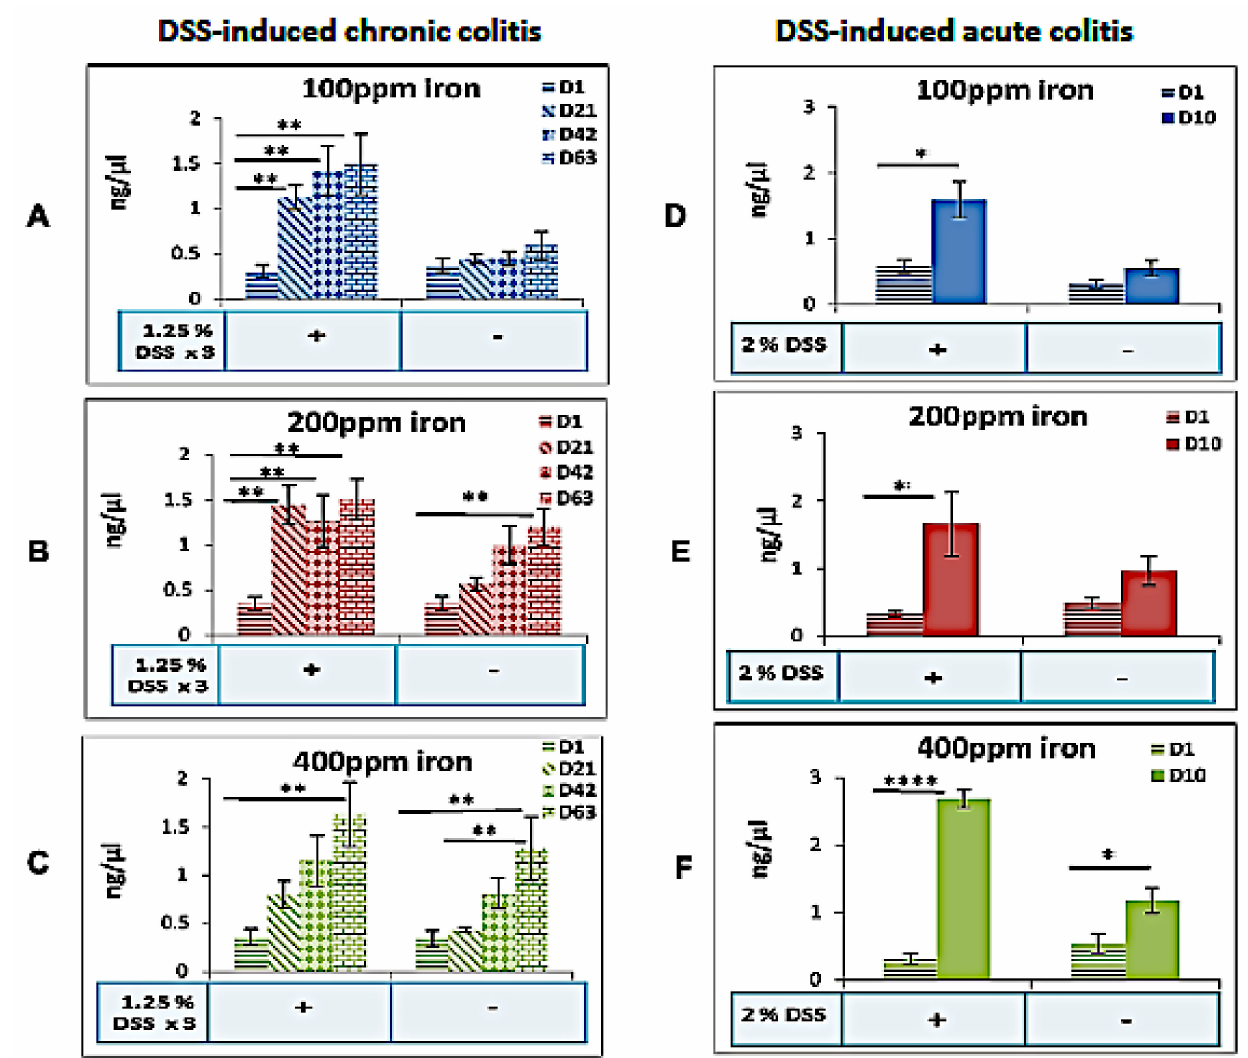
Figure 3. Fecal iron changes in mice fed differing iron diets in the presence or absence of colitis. Fecal iron concentrations in the presence or absence of DSS-induced chronic DSS (day-1 vs. day-21, day-42, and day-63; n = 8 mice per group) or acute colitis DSS (day-1 vs. day-10; n = 4 mice per group), for mice consuming a ( A , D ) deficient (100 ppm iron), ( B , E ) standard (200 ppm iron) or ( C , F ) supplemented (400 ppm iron) chow diet respectively. Data are presented as a mean ± standard error of the mean (SEM). Differences were tested by Kruskal–Wallis test followed by multiple comparison Dunn’s test; * p < 0.05, ** p < 0.01, **** p <